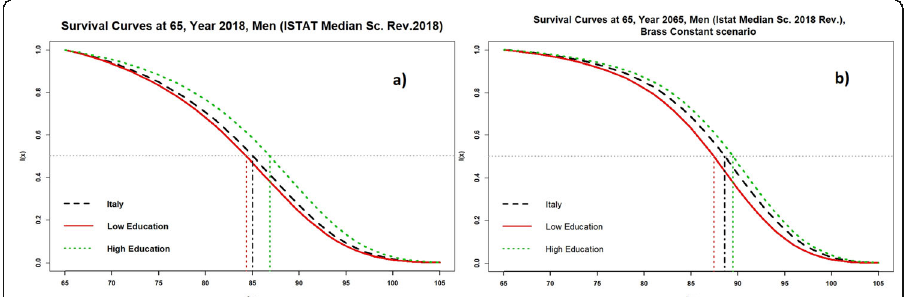
Fig. 3 Survival curves at age 65 for men, low vs high education level and the whole male Italian population. a Year 2018. b Year 2065. Source: ISTAT official forecasts (Median Scenario, 2018 Revision) and our own projections (Brass Constant)